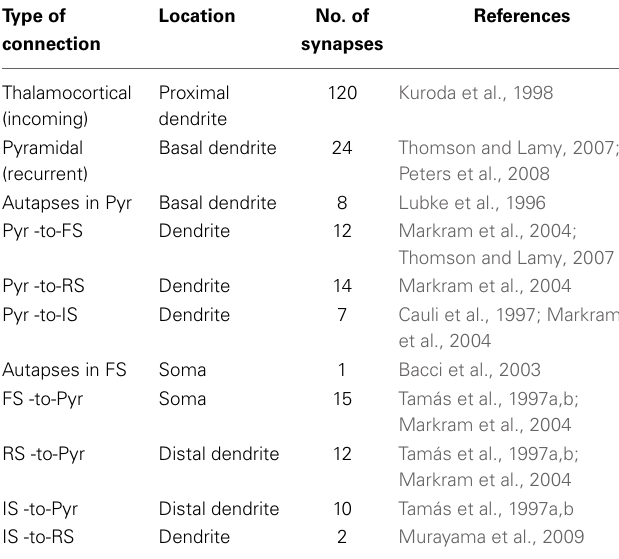
Table 5 | Summary of synaptic connections in the microcircuit.